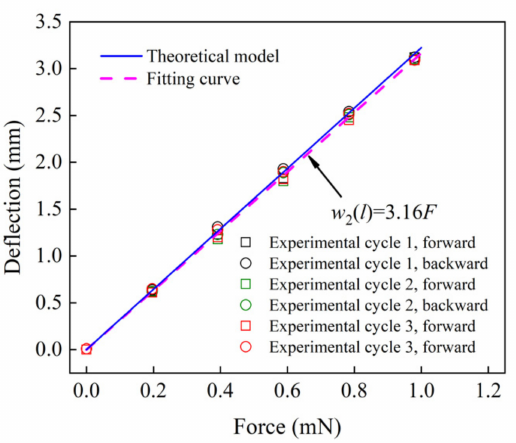
Figure 15. The deflection with the force applied at the free end of the tactile sensor.